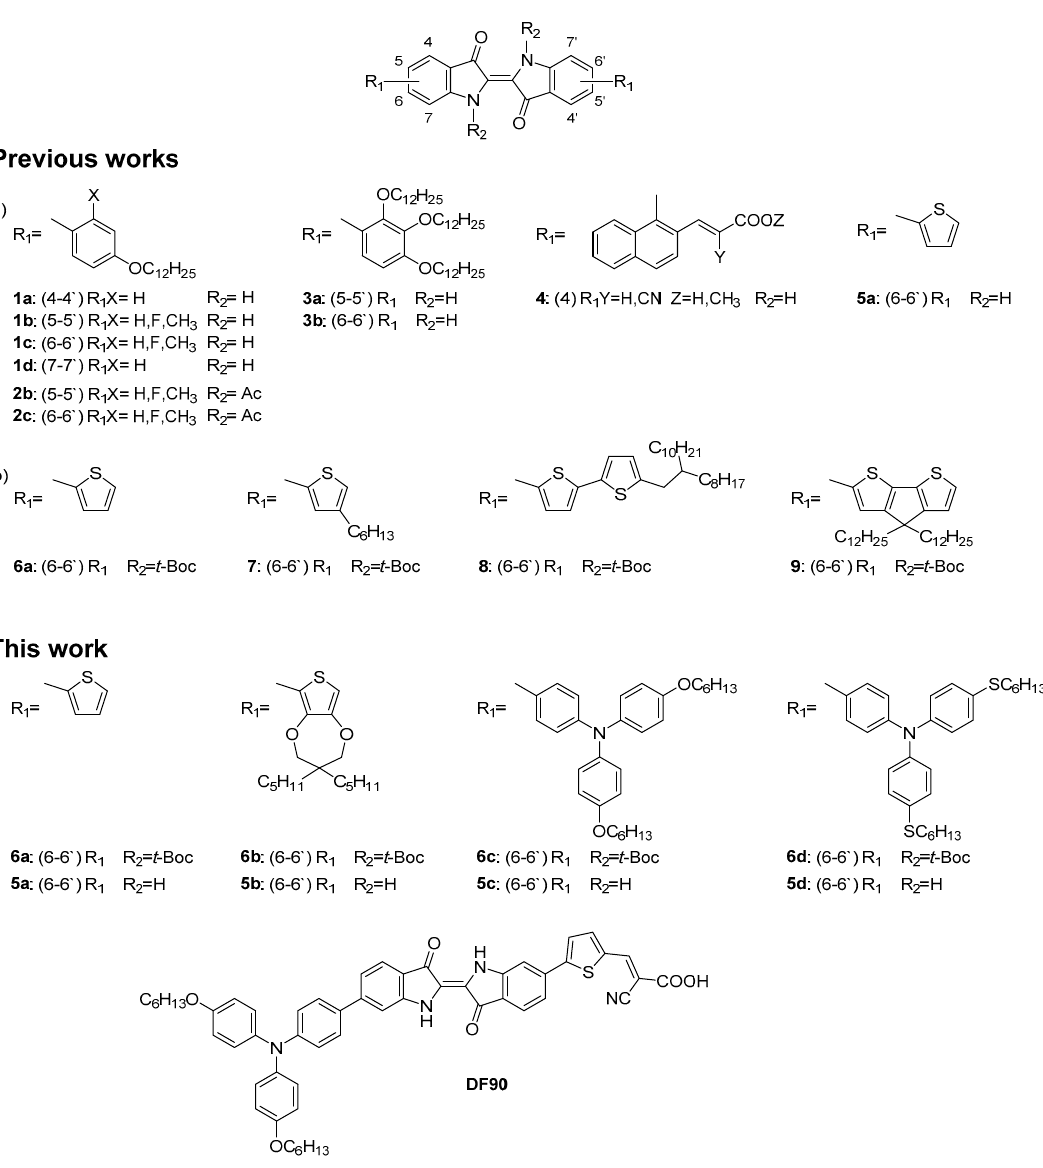
Figure 2. Conjugated indigo derivatives reported in the literature and dyes developed in this study. ( a ) non t -Boc-protected compounds; ( b ) t -Boc-protected